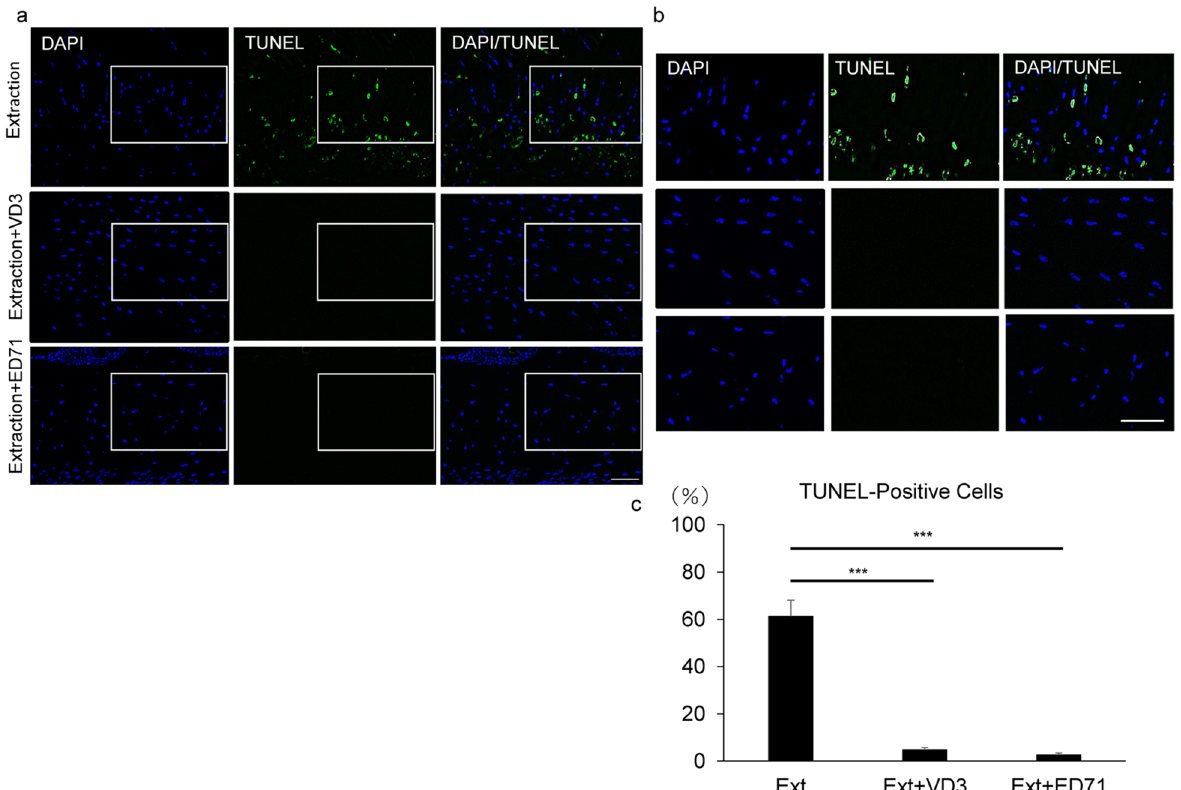
Figure 4. Osteocyte apoptosis is significantly blocked by VD3 and ED71. ( a , b ) C57BL/6 mice were administered zoledronate (500 μg/kg) or vehicle (PBS) once a week for 2 weeks and ED71 (0.5 µg/kg) or 1,25(OH) 2 D 3 (VD3) (0.5 µg/kg) intraperitoneally twice a week and then the right first and second molars in the mandibles were extracted. Four days later, bone sections from mice with zoledronate + tooth extraction (Extraction), VD3 + tooth extraction (Extraction + VD3) or ED71 + Zoledronate + (Zoledronate + ED71) were prepared and labeled with Biotin-dUTP using terminal deoxynucleotidyl transferase (TdT), followed by Avidin- DTAF as TUNEL staining (TUNEL) to identify apoptotic cells. Nuclei were visualized by DAPI. Sections were observed under a fluorescence microscope. ( c ) Data showing mean percentage (%) of TUNEL-positive relative whole osteocytes in bone ± SD (each with n = 5, ***P < 0.001). Representative data are shown of at least two independent and identical experiments, each with n = 5. Bar = 100